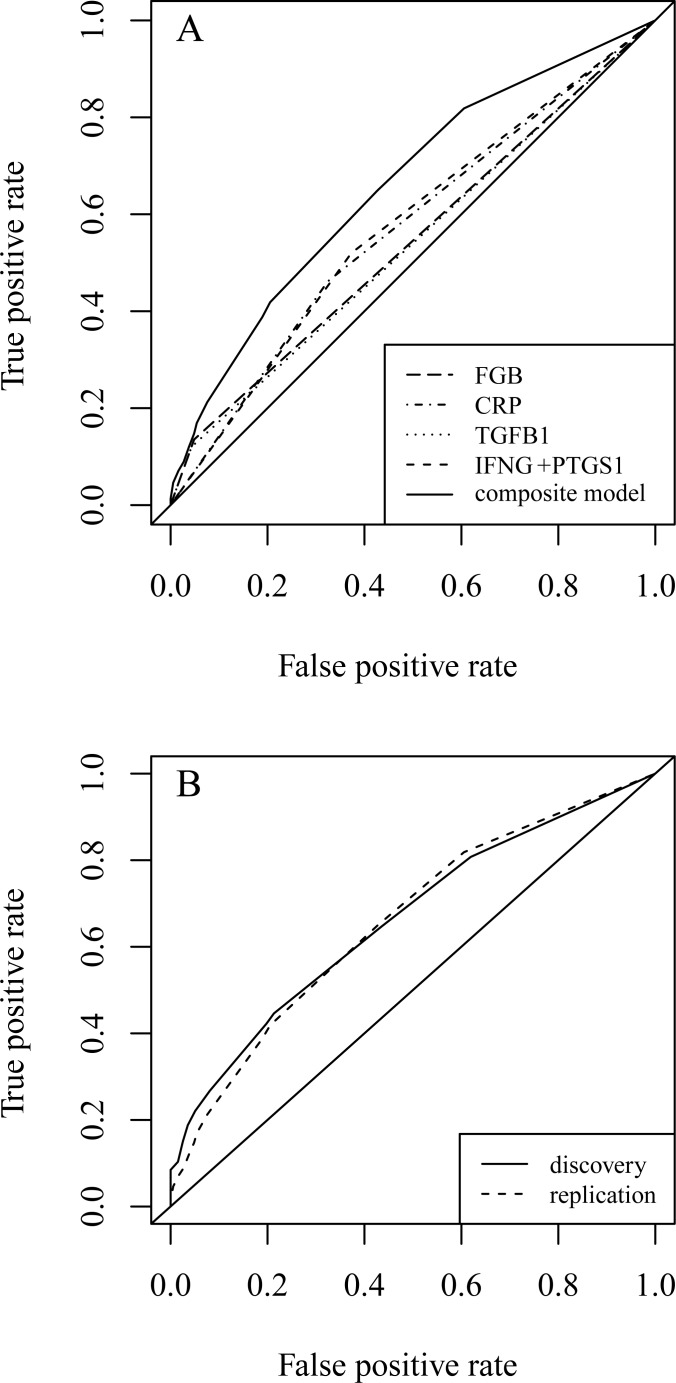
ROC curves demonstrate usefulness of the additive composite model built from all identified genetic markers.
A. Comparing performance of the composite model to the performance of each single marker in the Moscow discovery sample. Combining the high specificity of CRP and IFNG+PTGS predictors (the left hump) with relatively high sensitivity of TGFB1 and FGB (the right hump) yields a much better classifier. B. Performance of the model stays the same when tested on the independent replication sample (Bashkortostan).